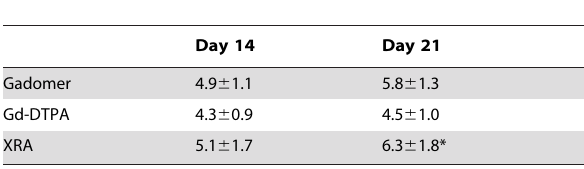
Table 1. Number of identified collateral